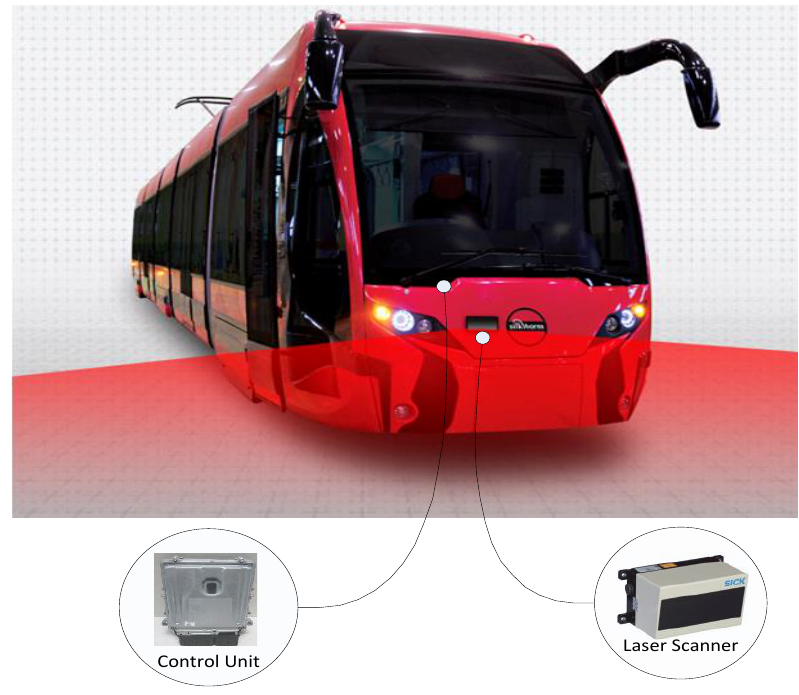
Figure 1. Ladar Digital-Multilayer Range Scanner (LD-MRS) laser scanner mounted in front of the test vehicle named “Silkworm” which is manufactured by Durmazlar Machine Inc. and control unit of the test vehicle.